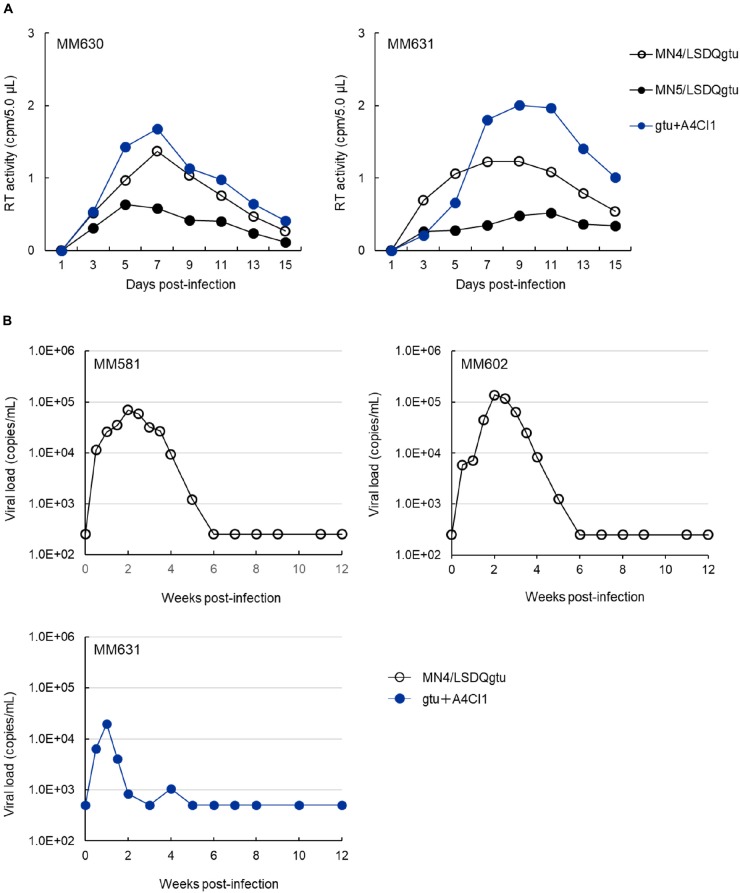
Growth property of HIV-1rmt clones in rhesus PBMCs and individuals. (A) Viral replication kinetics in rhesus PBMCs infected with CXCR4-tropic MN4/LSDQgtu, CCR5-tropic MN5/LSDQgtu, or CCR5-tropic gtu + A4CI1. PBMCs were prepared from rhesus macaques MM630 and MM631, and spin-infected with cell-free viruses obtained from transfected 293T cells as previously described (Nomaguchi et al., 2013b, 2014). Cell numbers and input viral amounts used were 2.0 × 106 and 4.1 × 106 RT units, respectively. (B) Kinetics of plasma viral loads in rhesus macaques inoculated with CXCR4-tropic MN4/LSDQgtu or CCR5-tropic gtu + A4CI1. Rhesus macaques MM581, MM602, and MM631 were infected with cell-free viruses obtained from transfected 293T cells, and monitored for viral RNAs in plasma as previously described (Otsuki et al., 2014; Ishida et al., 2016). MM581 and MM602 were inoculated intravenously with 4.3 × 105 TCID50 of MN4/LSDQgtu as determined in a macaque cell line HSC-F (Akari et al., 1999). MM631 was inoculated with gtu + A4CI1 intravenously (5.0 × 106 TCID50 in HSC-F cells) and intraperitoneally (1.5 × 107 TCID50 in HSC-F cells). Infection experiments (MM581/MM602 and MM631) were separately and independently conducted, and the detection limits for the MM581/MM602 and MM631 experiments were 250 and 500 copies/ml, respectively. The TRIM5 genotypes as analyzed by the previously described method (Wilson et al., 2008) for MM581, MM602, MM630, and MM631 are TRIM5TFP/TFP (Mamu-1/Mamu-3), TRIM5TFP/TFP (Mamu-3/Mamu-3), TRIM5TFP/TFP (Mamu-3/Mamu-3), and TRIM5Q/Q (Mamu-4/Mamu-4), respectively.